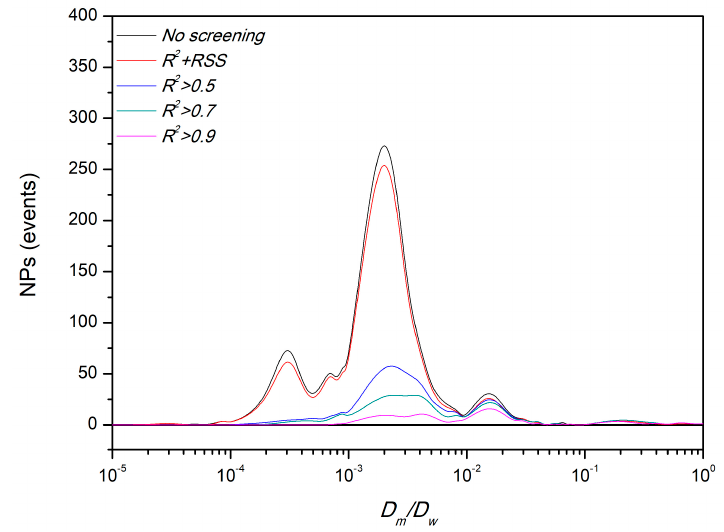
Figure 6. Distribution of D m / D w results of non-digested lipid nanocarrier after following different goodness-of-fit screenings.